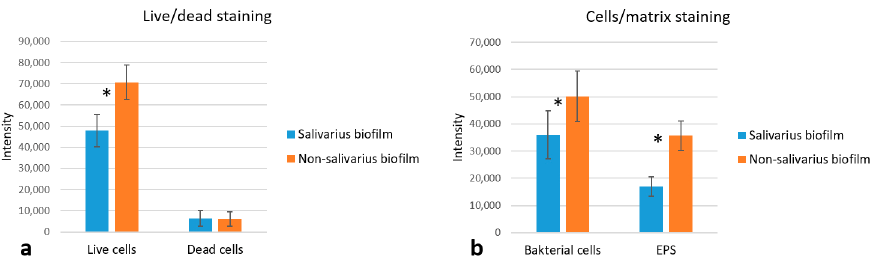
Figure 8. The average fluorescence intensity of the different experimental groups ( n = 15). The asterisk (*) indicates statistically significant differences between the groups ( p < 0.05); ( a ) Live/dead staining; ( b ) Cell/matrix staining .